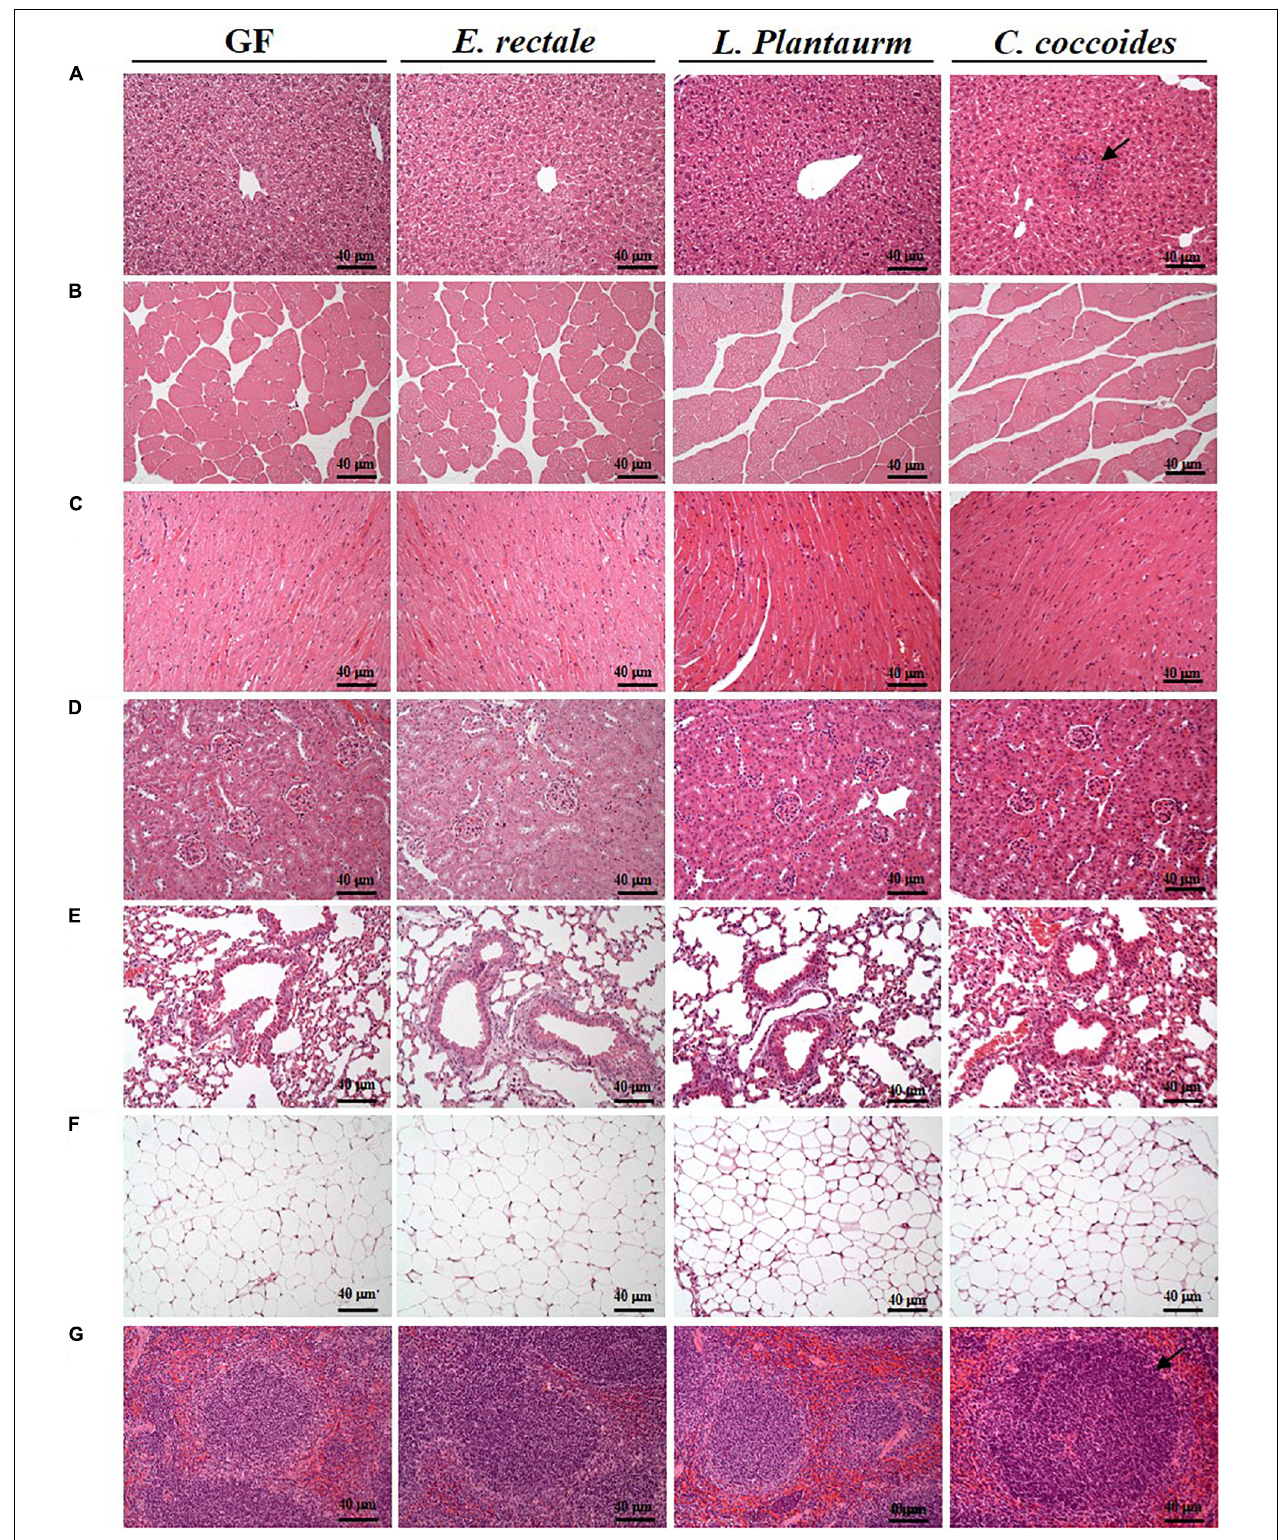
FIGURE 9 | Effect of indicated gnotobiotic groups on histomorphologic features of the liver (A) , muscle (B) , heart (C) , kidney (D) , lung (E) , EFP (F) , and Spleen tissue (G) . Specimens were photographed under a light microscope. (H&E stain, magnification: 200 × ; bar, 40 µ m). The arrows mean the necrosis and hypertrophy in the liver and spleen, respectively. EFP, Epididymal fat